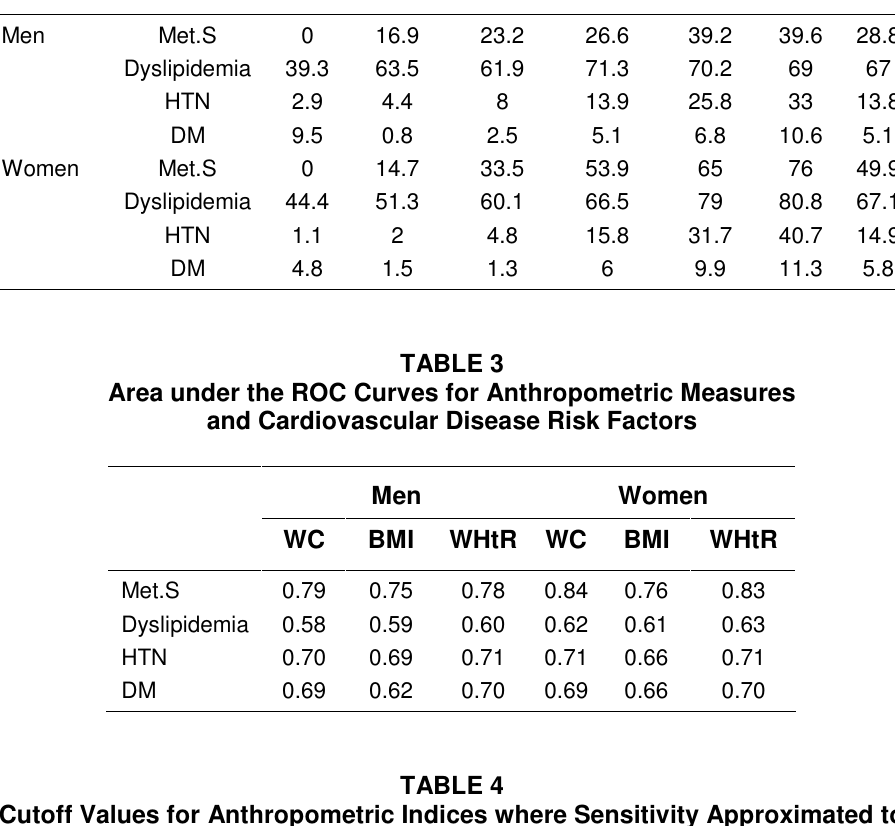
Cutoff Values for Anthropometric Indices where Sensitivity Approximated to Specificity when Predicting Individual and Multiple Risk Factors for Men and Women Men Women WC (cm) BMI (kg/m 2 ) WHtR WC (cm) BMI (kg/m 2 ) WHtR